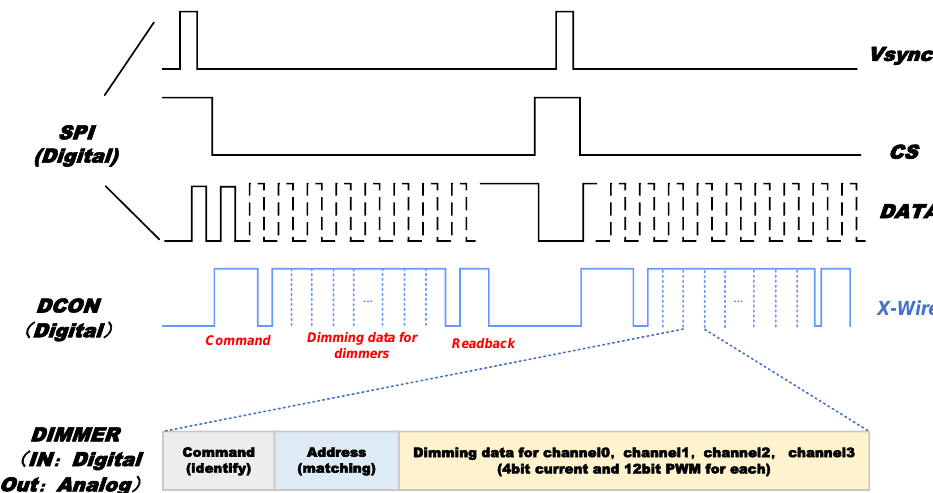
Figure 3. The data format of DCON received (black) and sent (blue).